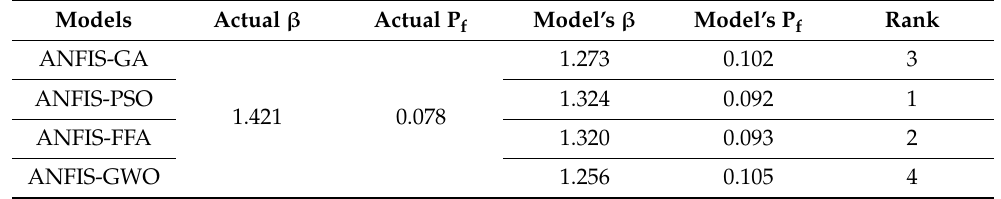
Table 5. Comparison of different models on the basis of reliability index ( β